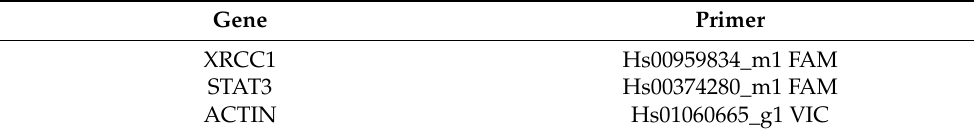
Table 3. TaqMan primers.